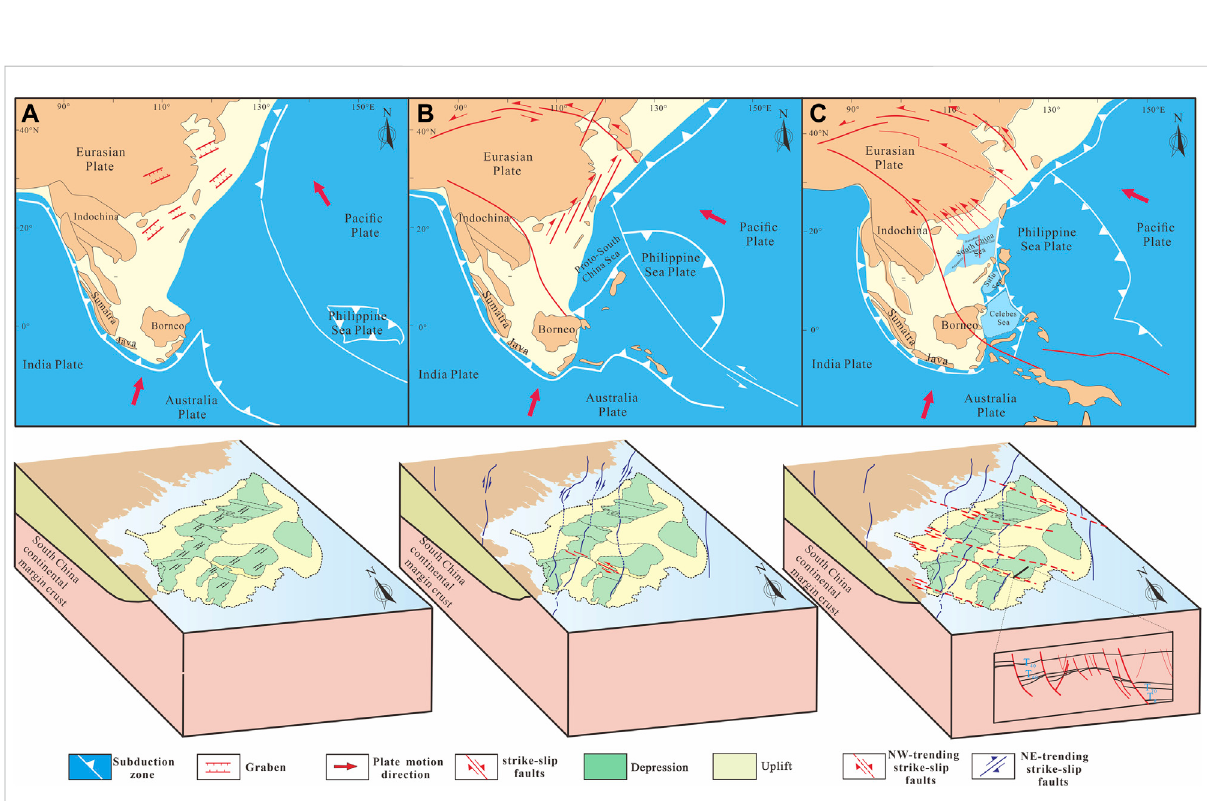
FIGURE 15 Simpli fi edmodel showing three-stageextension and geodynamics intheCenozoicPRMB (revisedfrom Hall, 2012;Li Set al., 2022; Wang et al., 2022). (A) -55 Ma; (B) -35 Ma; (C) -20